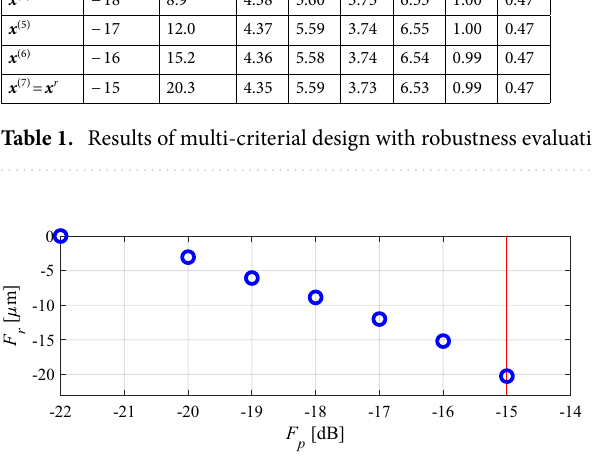
Figure 6. Bandpass filter of Fig. 5: trade-off designs (performance vs. robustness) generated using the multi- criterial optimization procedure of “Multi-criterial tuning of microwave circuits with explicit robustness handling”. The maximal acceptable reflection level within the frequency band of interest is marked using vertical